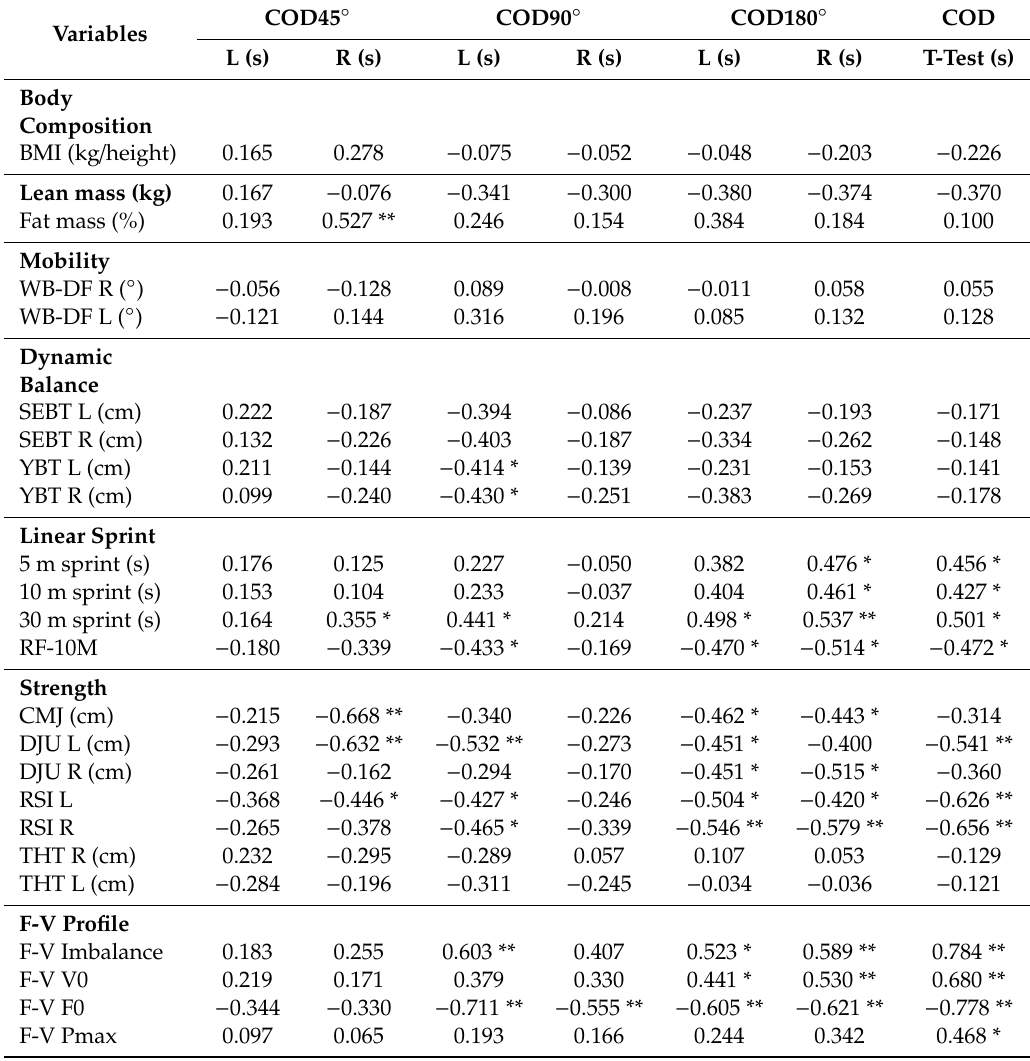
Table 3. Association matrix between COD and body composition, mobility, dynamic balance, linear sprint, and